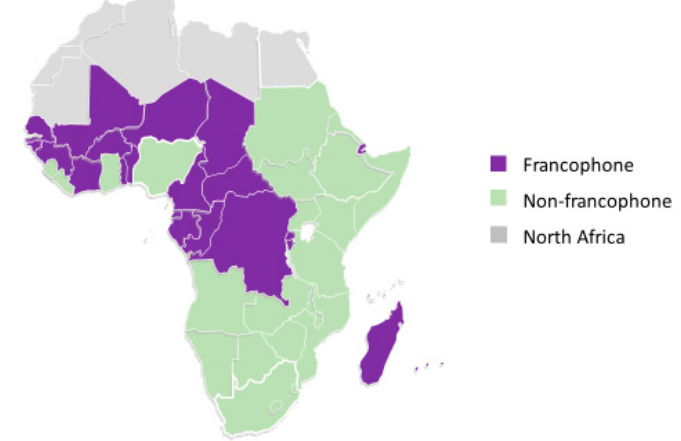
Figure 1. Geographical Distribution of Sub-Saharan African Countries by Francophone Status.